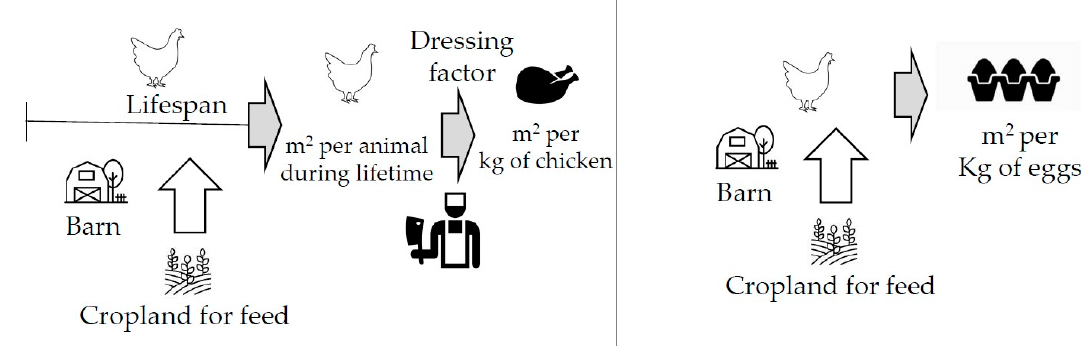
Figure 5. Chicken meat and egg production systems. Source of icons: the Noun Project (2018).